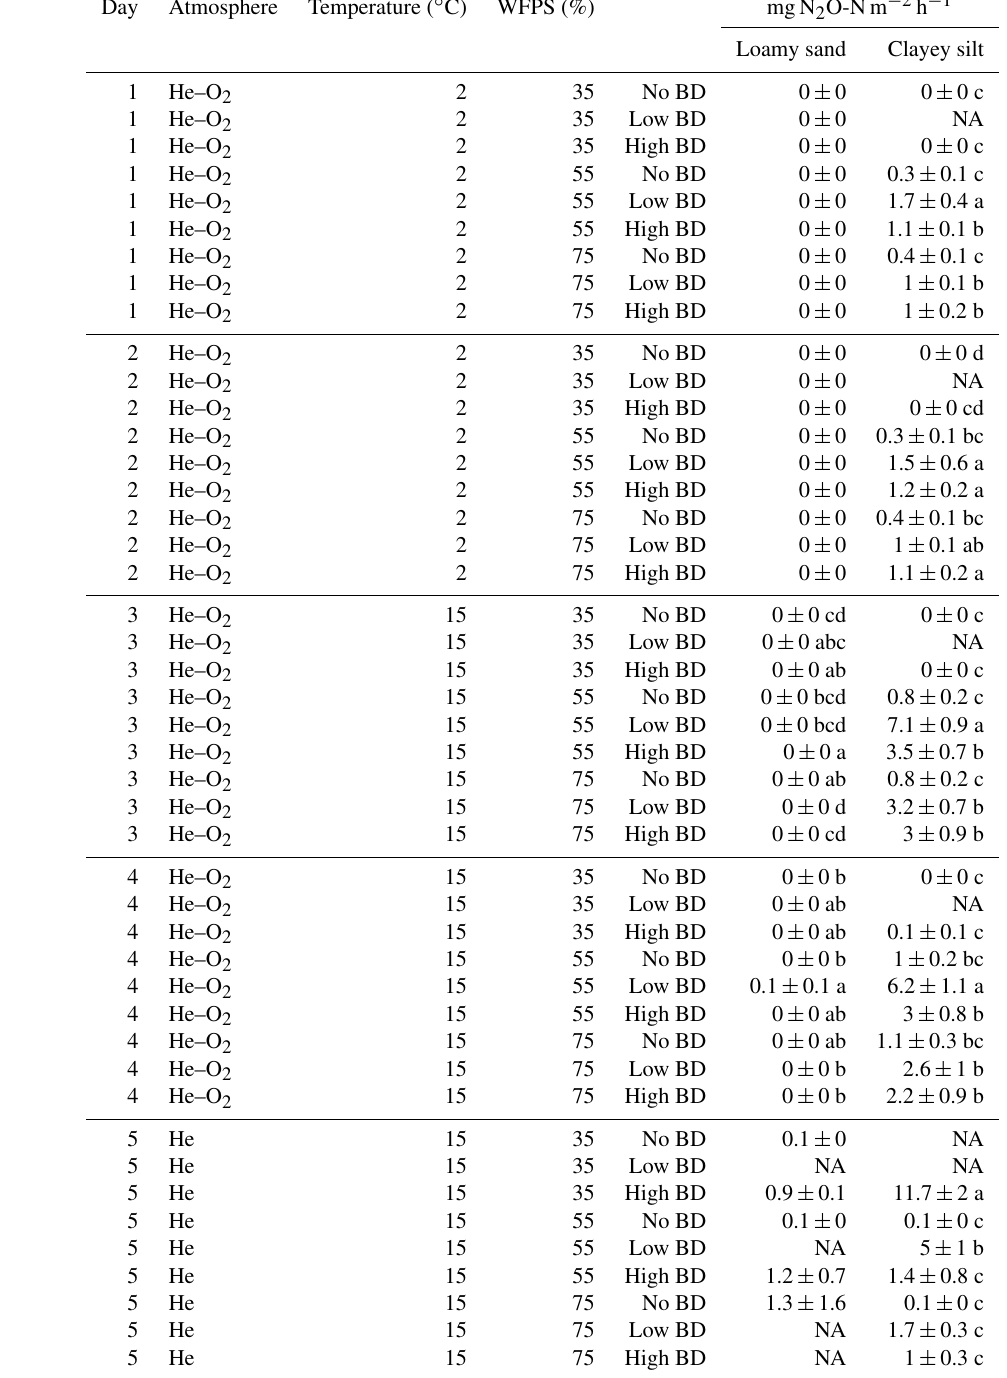
Table A2. Mean N 2 O-N fluxes with standard deviations in mgm − 2 h − 1 from the loamy sand and the clayey silt, treated with different water- filled pore spaces (WFPSs, %), amounts of digestate (0mL per sample ring: no BD, 17.6mL: low BD and 35.2mL: high BD) and different temperature regimes ( ◦ C) under aerobic (He–O 2 ) and anaerobic (He) atmospheres. The column “Day” denotes the consecutive measuring days of the respective incubation cycle. Different letters after fluxes indicate significant differences (Tukey’s HSD, p < 0.05) within each soil and measuring day. Zeros as last digits were